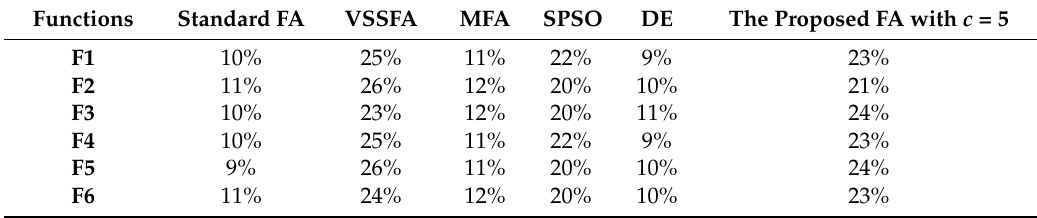
Table 6. The computational efficiency (EEF) of each method on the six problem sets.